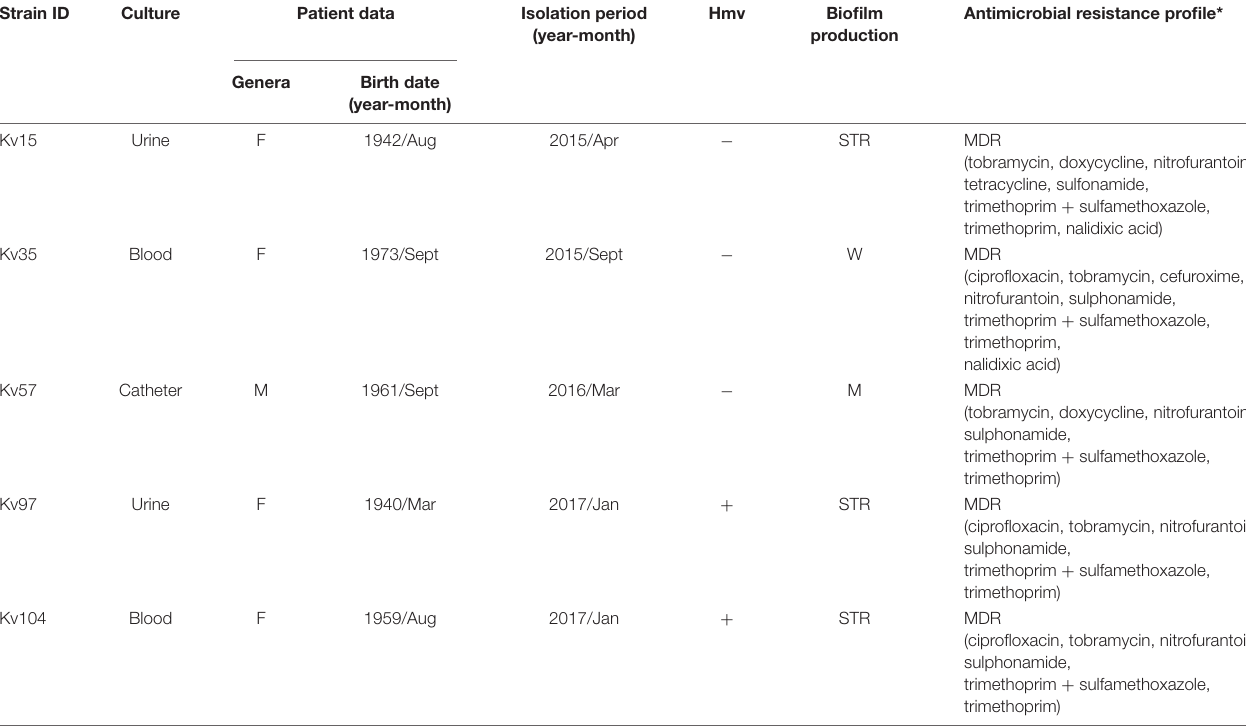
TABLE 1 | Isolation data, biofilm production, hypermucousviscous phenotype and antimicrobial resistance profile of Klebsiella variicola strains.